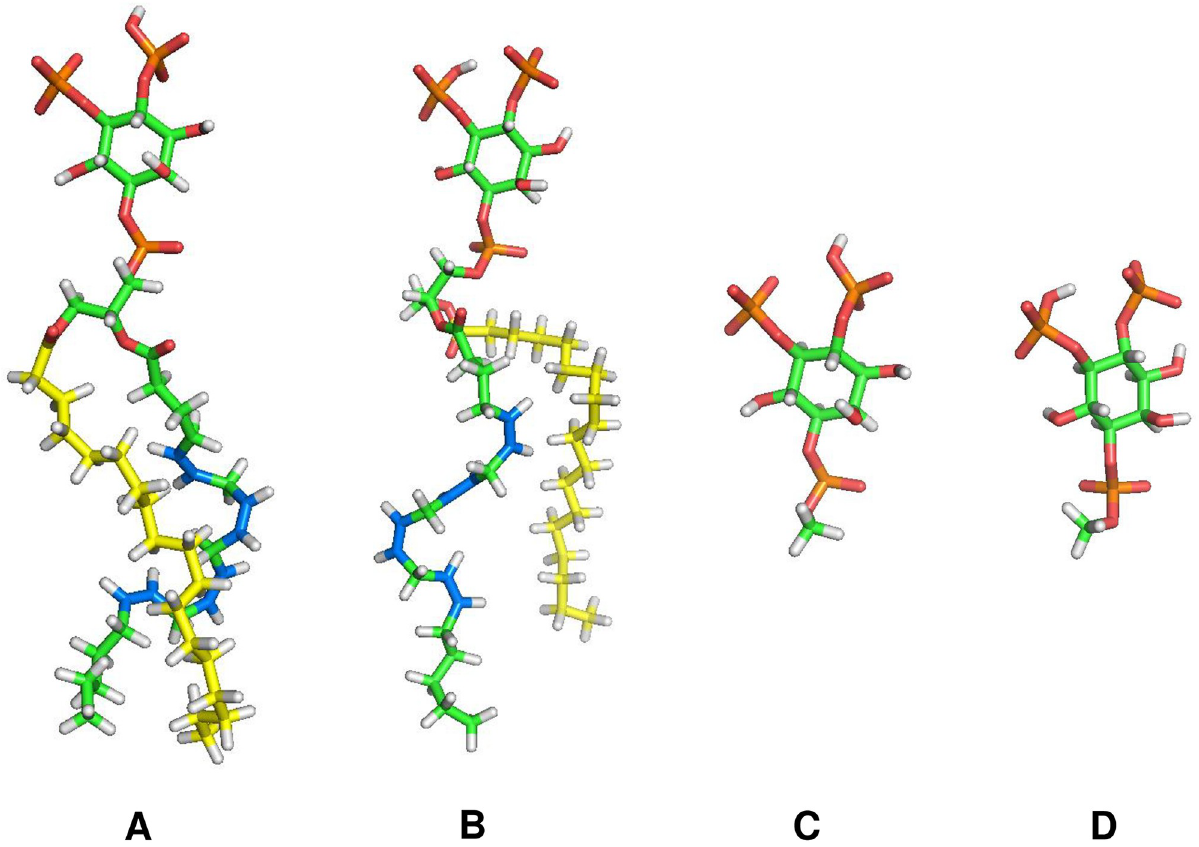
Fig 3. PIP 2 structures used in MD simulations (A and B) and docking calculations (C and D). A PIP 2 headgroup singly-protonated at 4-phosphate on inositol ring and with stearic (18:0) and arachidonic (20:4) acid chains; B preceding PIP 2 singly-protonated at 5-phosphate; C headgroup of A ; D headgroup of B . Coloring: hydrogen, white; oxygen, red; phosphate, orange; saturated carbon on steric acid chain, yellow; unsaturated carbon on arachidonic acid chain, blue; all other saturated carbons, green.